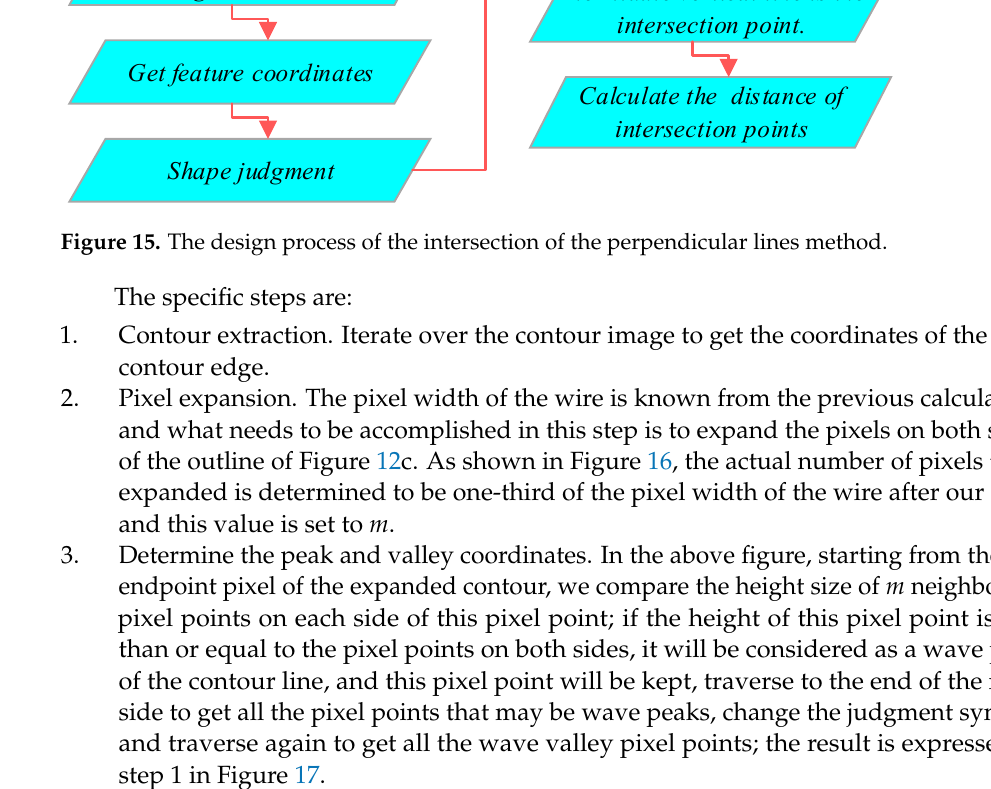
Figure 16. Schematic diagram of pixel